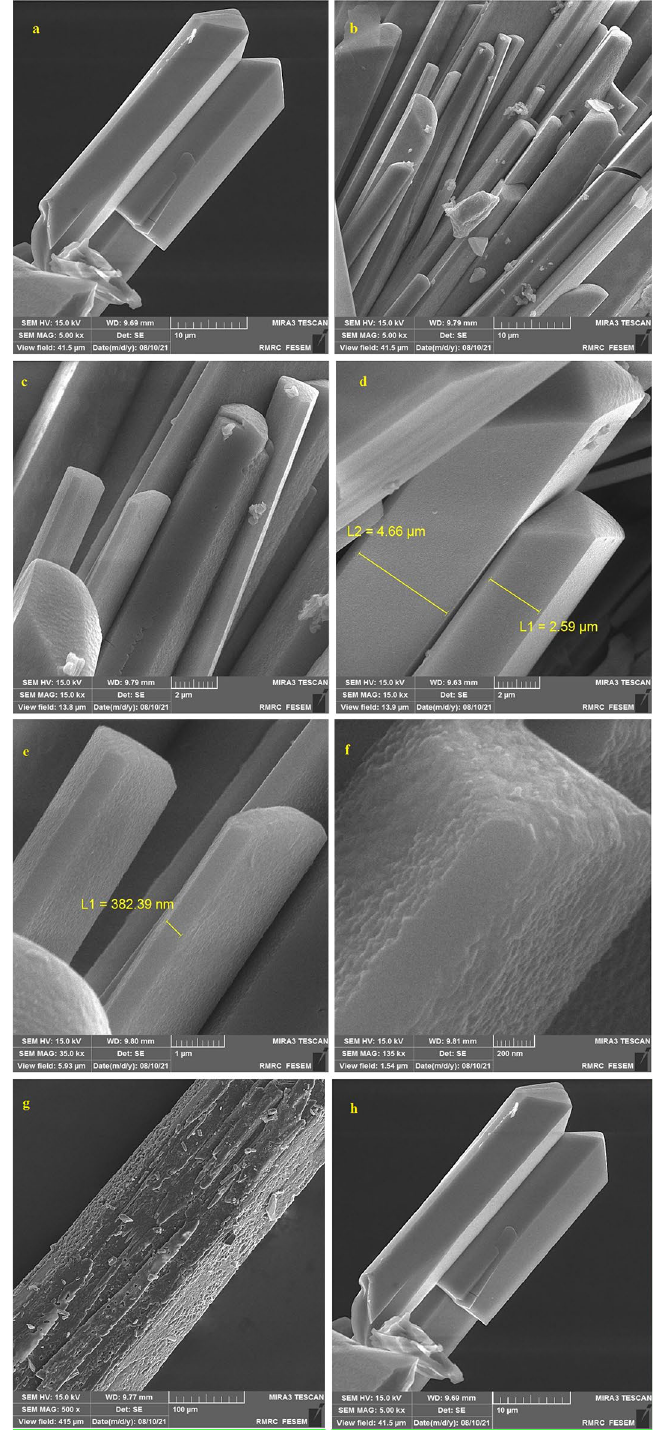
Figure 5. SEM images of Mo-metal–organic framework